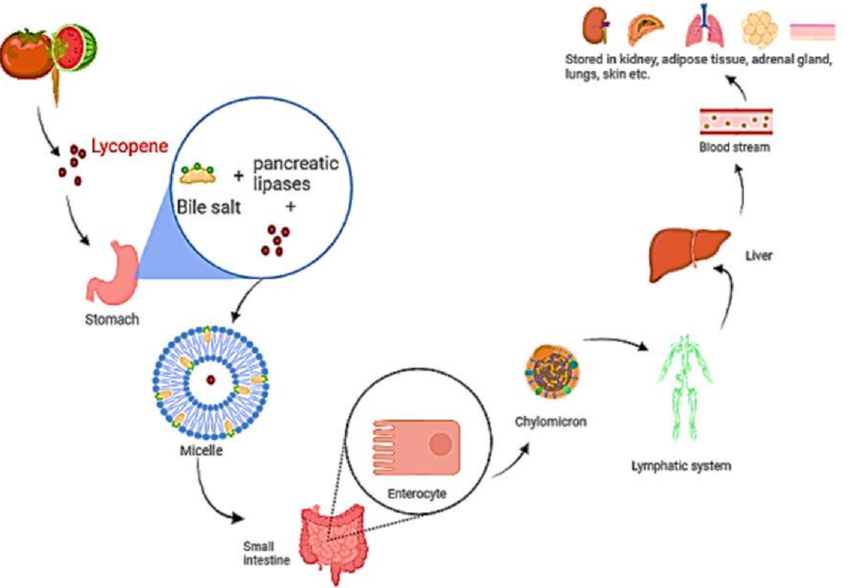
Figure 4. A diagram depicting the digestion and absorption of lycopene. Food releases lycopene, which is then integrated into micelles containing bile salt, cholesterol, and fatty acids. The micelle approaches enterocytes, and lycopene diffuses over the apical membrane in a passive manner. Lycopene is packed with other dietary lipids inside the enterocyte to form chylomicrons, which are carried over the basolateral membrane, into the lymphatic system, and subsequently discharged into the